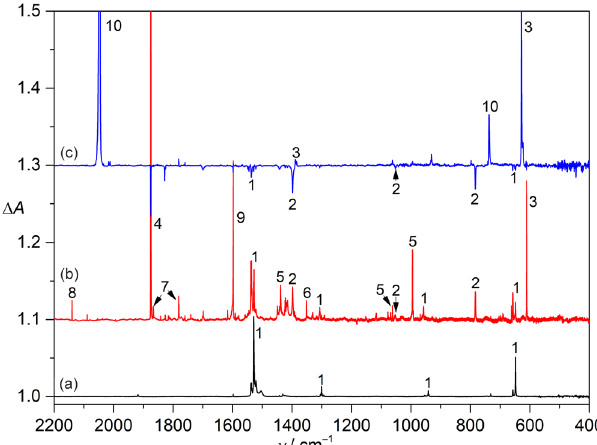
Fig. 2 IR spectra showing the generation and photochemistry of CH 3 S (cid:129) (2). a IR spectrum of CH 3 SNO in N 2 -matrix at 10 K. b IR spectrum of the high-vacuum fl ash pyrolysis (HVFP) products of CH 3 SNO in N 2 -matrix. c IR difference spectrum re fl ecting the change of the HVFP products upon UV- light irradiation (365 nm, 15 min). The IR bands for CH 3 SNO ( 1 ), CH 3 S (cid:129) ( 2 ), (cid:129) CH (cid:129) NO ( 4 ), H 3 ( 3 ), 2 CS ( 5 ), SO 2 ( 6 ), N 2 O 2 ( 7 ), CO ( 8 ), H 2 O ( 9 ), and N 2 S ( 10 ) are labeled.